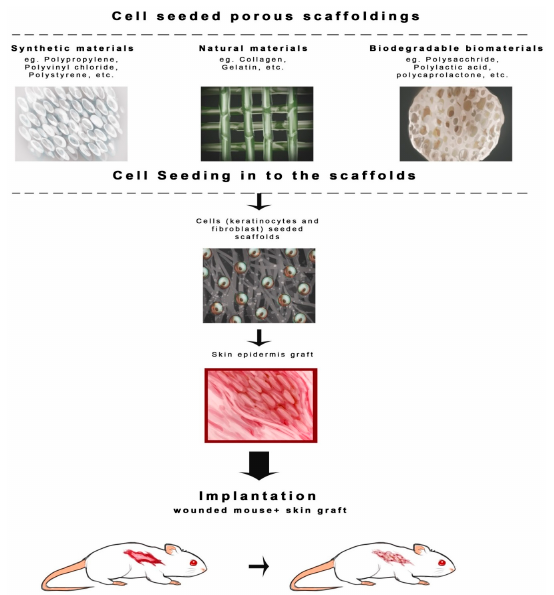
Figure 2. Porous scaffolding using various biomaterials. Various natural, synthetic and biodegradable materials are used for generation of highly porous scaffolds. These scaffolds provide a suitable environment for cell growth and proliferation. The porous nature of such scaffolds facilitates the regular supply of nutrients and oxygen for the skin cells, such as keratinocytes and fibroblasts. The full thickness skin grown on such scaffolds is used for wound transplant.